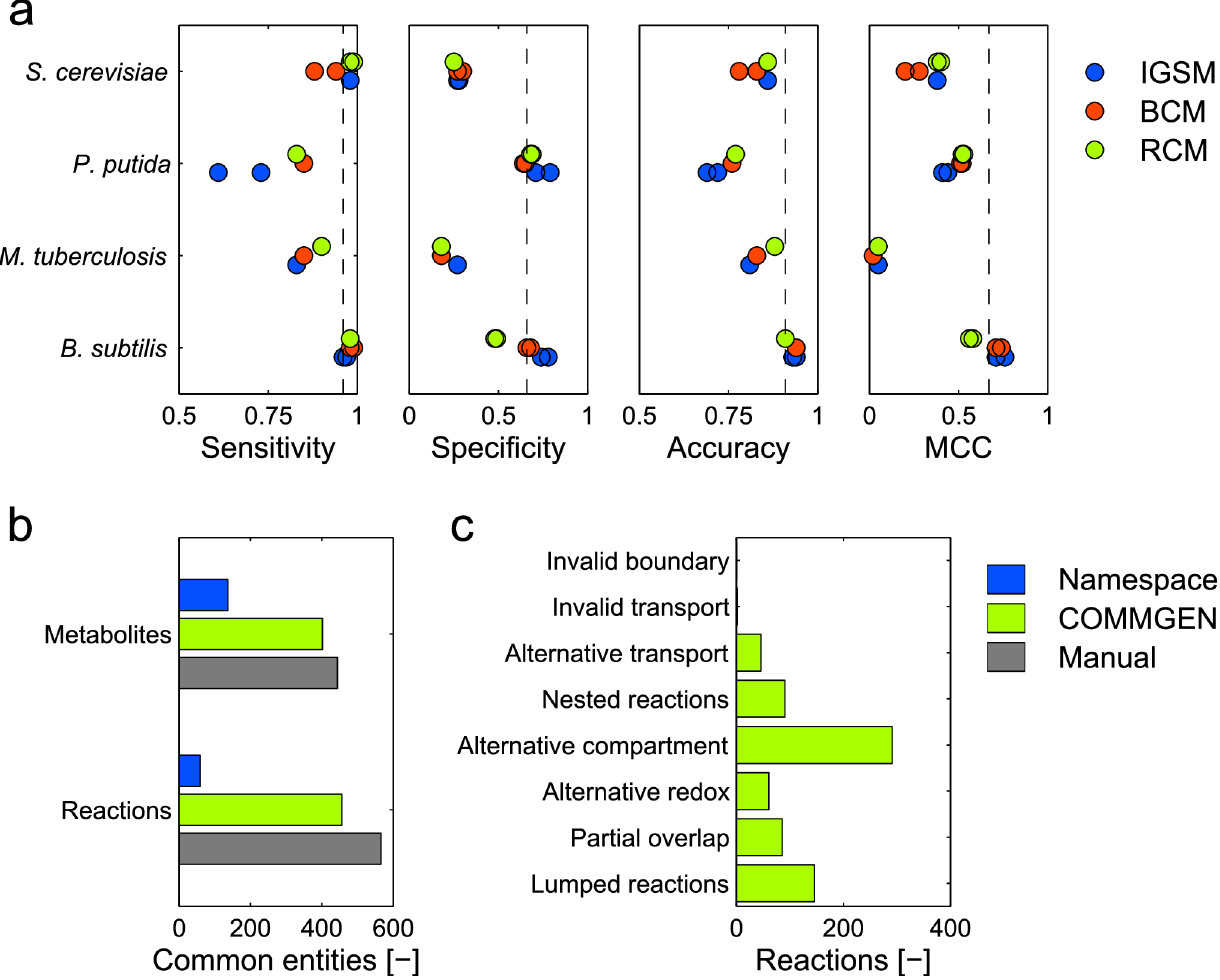
Fig 5. Performance evaluation of COMMGEN. ( a ) Evaluation of GSM ability to predict growth phenotypes. Predictive ability of initial GSMs (blue), basic consensus models (red), and automatically created refined consensus model (green) according to the metrics defined in the text. The test data comprised gene knockout data ( B . subtilis [3,36], P . putida [8,50], M . tuberculosis [51], S . cerevisiae [49]), biolog data ( B . subtilis [3,36], P . putida [8,33]) and auxotrophies ( P . putida [50]). See S3 Protocol for details. ( b,c ) Comparison of manual (yeast consensus model [20] based on the IGSMs iMM904 [37] and iLL672 [38]) and automatic consensus model generation with namespace matching only, or with COMMGEN. ( b ) Numbers of common reactions and metabolites for manual curation, name space conversion, and automatically created refined consensus model. ( c ) Incidences of inconsistent reaction classes identified by